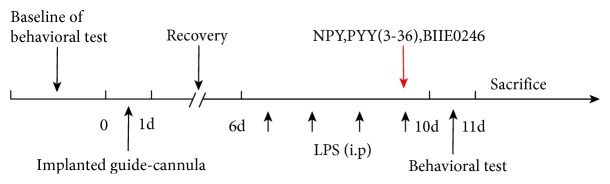
Time schedule for the experiment. LPS was injected for 4 days. Depressive-like behavior tests included OFT and SPT. NPY (1 nmol), Y2R agonist (PYY (3-36), 1 nmol), or Y2R antagonist (BIIE0246, 40 nmol) treatment were locally injected into the mPFC.